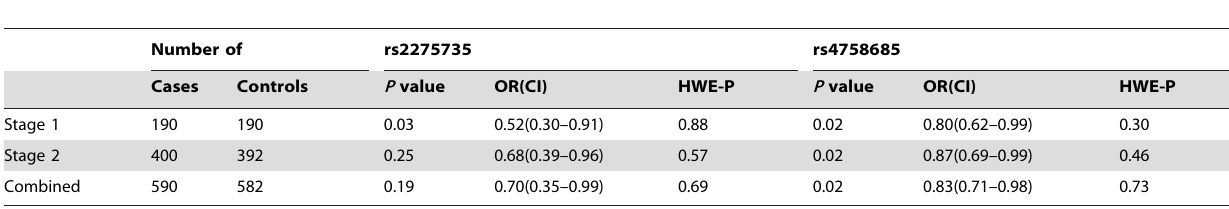
Table 3. Association results for 2 candidate CHD risk loci in stage 1, stage 2 and combined data.